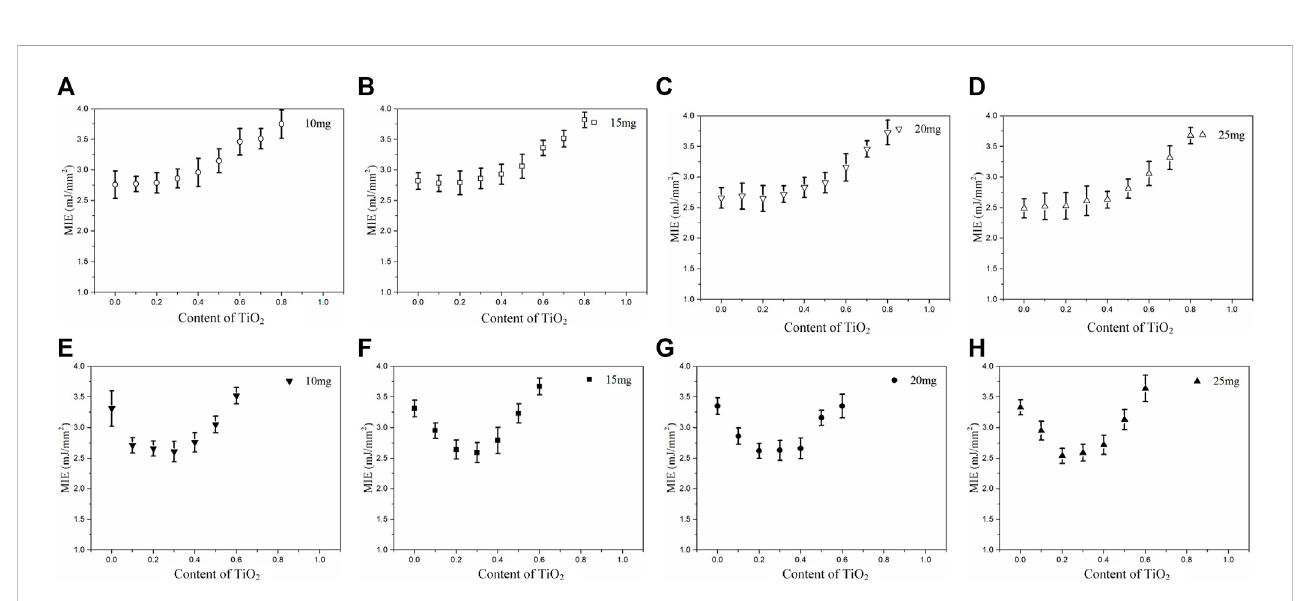
FIGURE 5 The minimum ignition energy. (A – D) different mass of (Fe/TiO 2 ), (E – H) different mass of (Al/TiO 2 ).